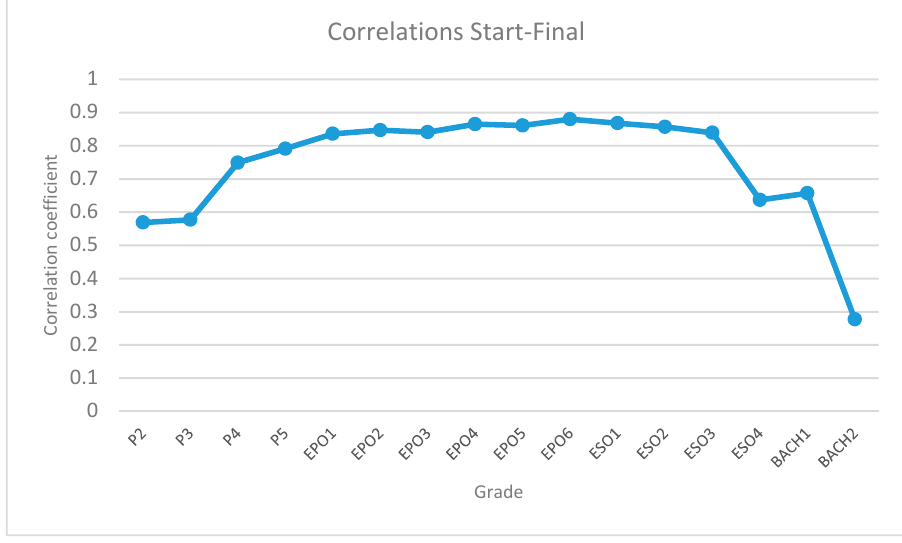
Figure 7. Correlation between the start level and the final level per school grade.